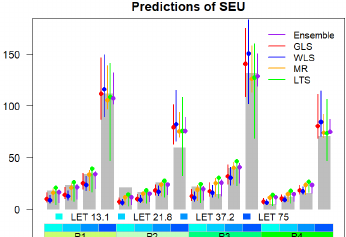
Figure 6. Evaluations, 95% confidence intervals and real values of the five methods on the validation set.